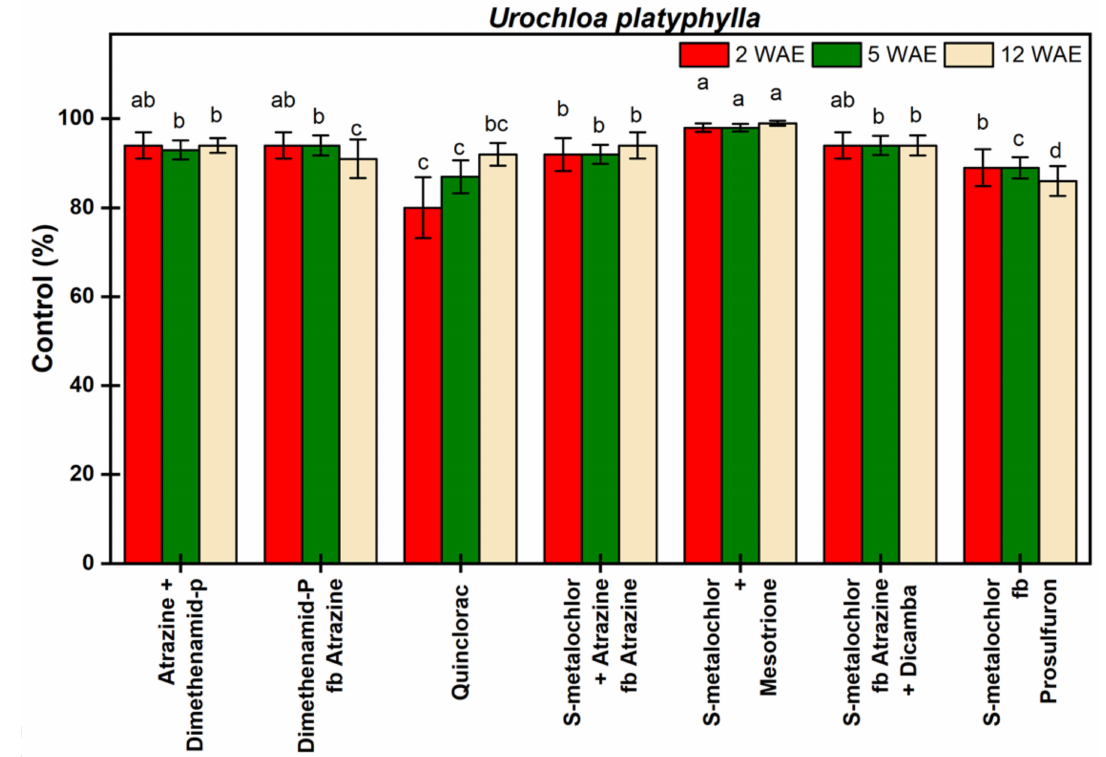
Figure 4. Urochloa platyphylla control with di ff erent herbicide treatments at 2, 5, and 12 weeks after emergence (WAE). Data were analyzed separately for each WAE. Data were pooled over three years. The same letters on bars indicate no significant di ff erences at p < 0.05, according to Fisher’s least significant di ff erence